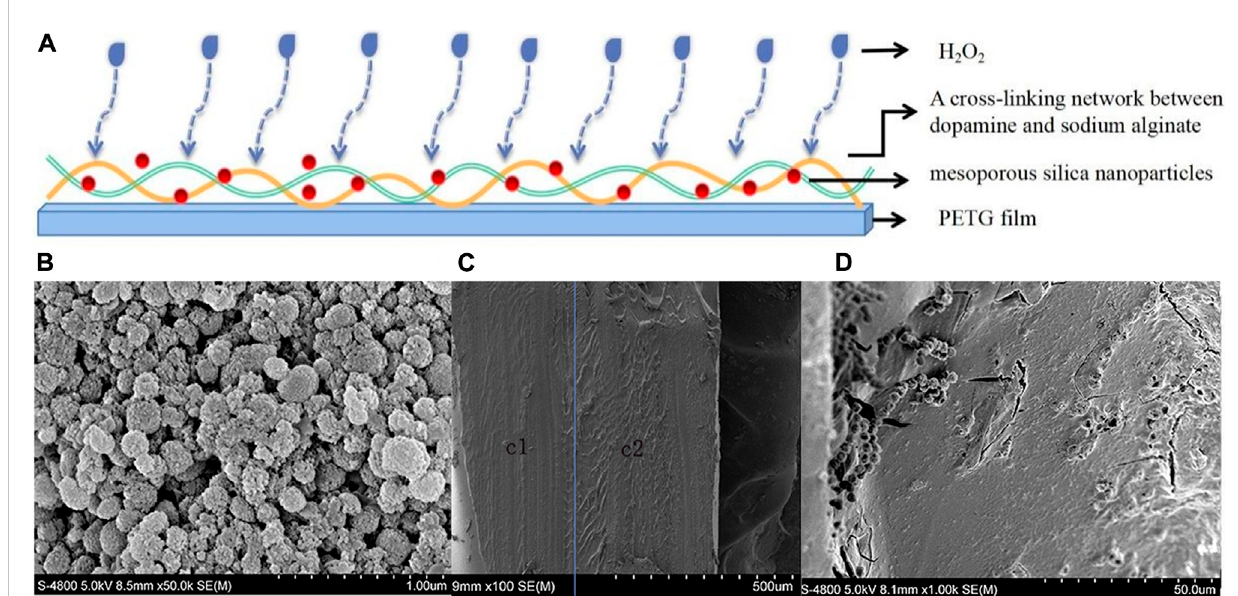
FIGURE 3 (A) Preparation of a thermoforming fi lm loaded with hydrogen peroxide sustained-release gel. (B) MSN observed at 50000× by SEM. (C) The composite gel layer was closely combined with the thermoforming fi lm when observed at 100× by SEM. c1was the thermoforming fi lm; c2 was the composite gel layer. (D) A large number of MSN were bound within the gel when observed at 10000× by